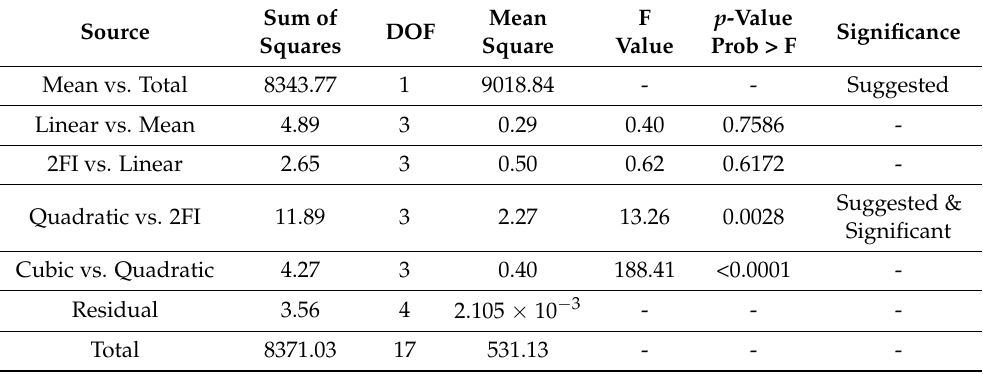
Table 5. Analysisresults ofthe significanceof eachorderand determinationof theorderof responsemodel. Sum of Mean F Source DOF Significance Squares Square Value Prob > F Mean vs. Total 8343.77 - Suggested Linear vs. Mean